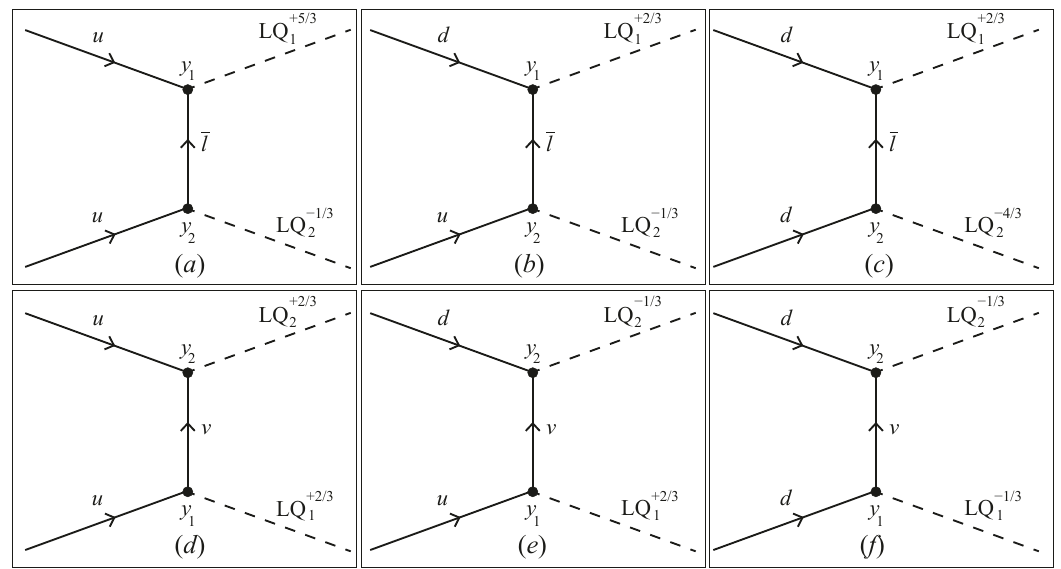
Figure 2 . The leading order Feynman diagrams for the novel leptoquark pair production at LHC, where the final state leptoquarks LQ and LQ have fermion numbers that differ by two. The 1 2 electric charges of the two leptoquarks, in units of an absolute value of the electron charge, are denoted with